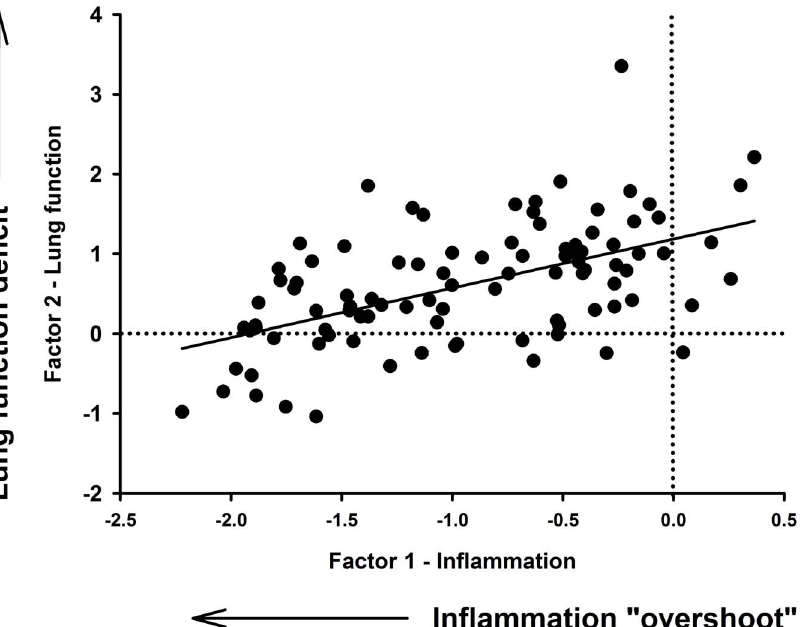
Figure 3. Deficits in lung function in response to inflammation were associated with corresponding decreases in inflammatory markers below baseline levels. Scatter plot showing the correlation (r=0.54) between Factor 2 (lung function) and Factor 1 (inflammation) from mice 7 days post-exposure to geogenic PM 10 . Mice with greater declines in inflammatory markers (below control levels) 7 days post-exposure tended to have better lung